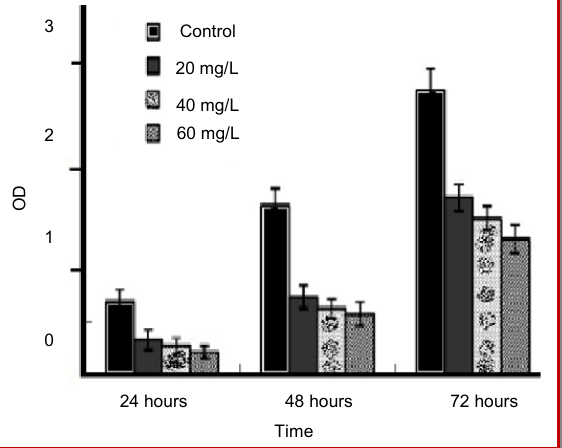
Figure 4: Schizophyllan effects on the MTT activity of CNS-1 cells